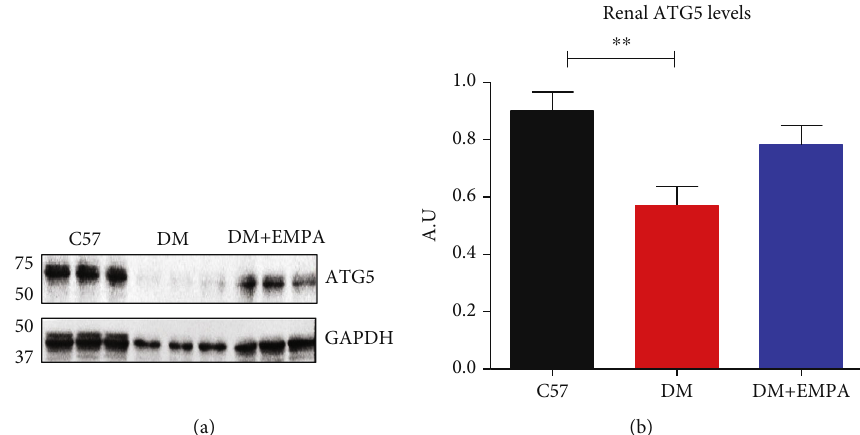
Figure 3: Renal ATG5 expression level in healthy control and DM and DM+EMPA mice. (a) Representative randomly Western blots of ATG5 protein levels in renal lysates. (b) The signals were quanti fi ed by densitometry, and the ratio between ATG5 and GAPDH signals in the three groups was calculated.